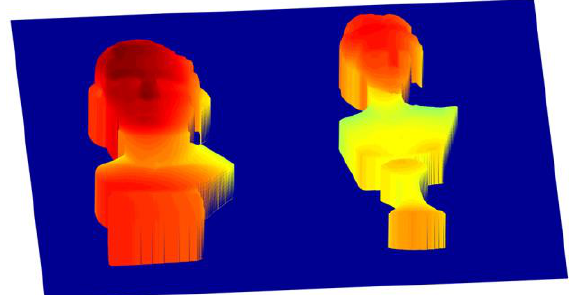
Figure 13. Measurement result of two isolated objects.